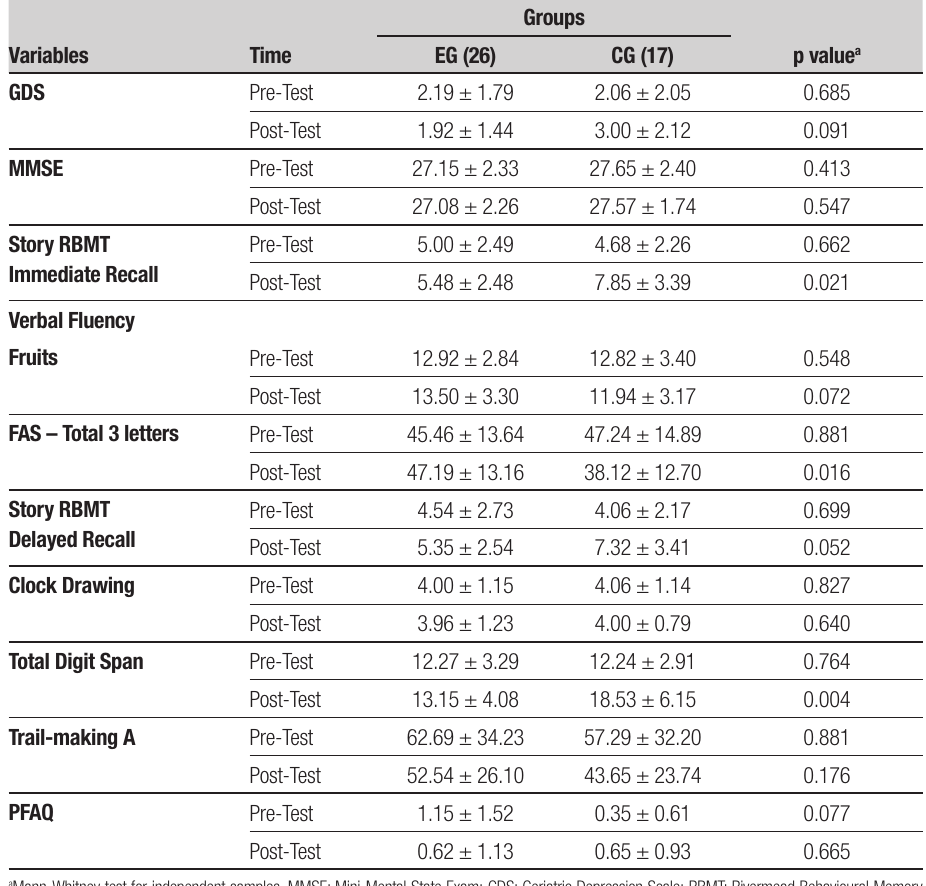
Table 2. Comparison of pre- and post-intervention test results of EG and CG for outcome